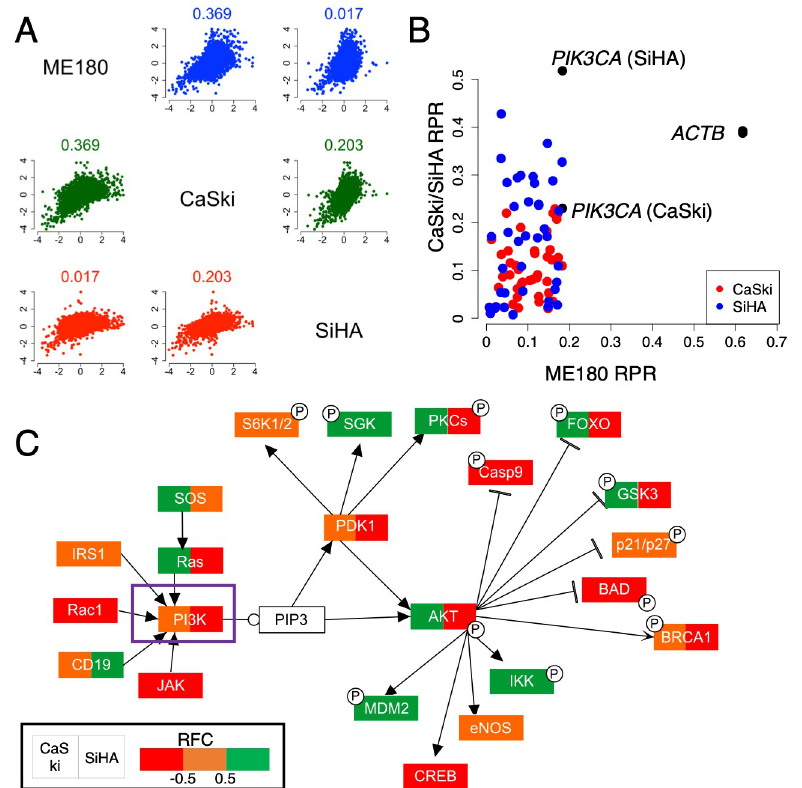
Fig 2. Off-target evaluation of polyamide 2. (A) Correlations between changes in expression (logFC) after treatment of 10 nM of polyamide 2 against DMSO across ME180, CaSki and SiHA cells; numerical values above each pairing indicate the pairwise Spearman’s rank correlation coefficient. (B) Distribution of the relative percentile rank (RPR) for on-target and off-target genes expressed as ME180/CaSki (red) or SiHA (blue) pairings. PIK3CA (on-target) or ACTB (control) is expressed in black. (C) Differential comparison of changes in expression across different cell lines in the PI3K-Akt pathway (KEGG accession: hsa04151), with ME180 as the baseline; colors indicate the level of RFC ( < -0.5, red; > 0.5, green), with divided boxes indicating nonuniform RFC behavior between CaSki/ME180 (left) and SiHA/ ME180 (right) pairings. PIP3, phosphatidylinositol-3,4,5-triphosphate. Full pathway illustrations can be found as S1 and S2